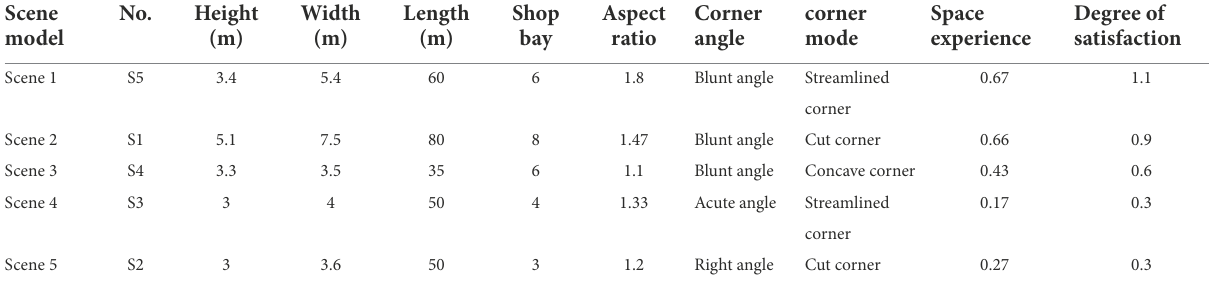
TABLE 2 Scores of cognitive evaluation of scene space.